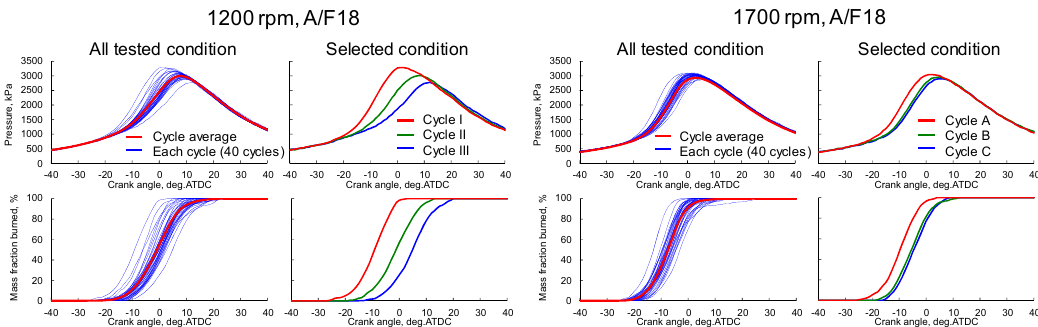
Figure 3. In-cylinder pressure traces ( top ) and mass fraction burnt ( bottom ) of all tested cases and selected cases for the two operating conditions (1200 rpm and 1700 rpm).